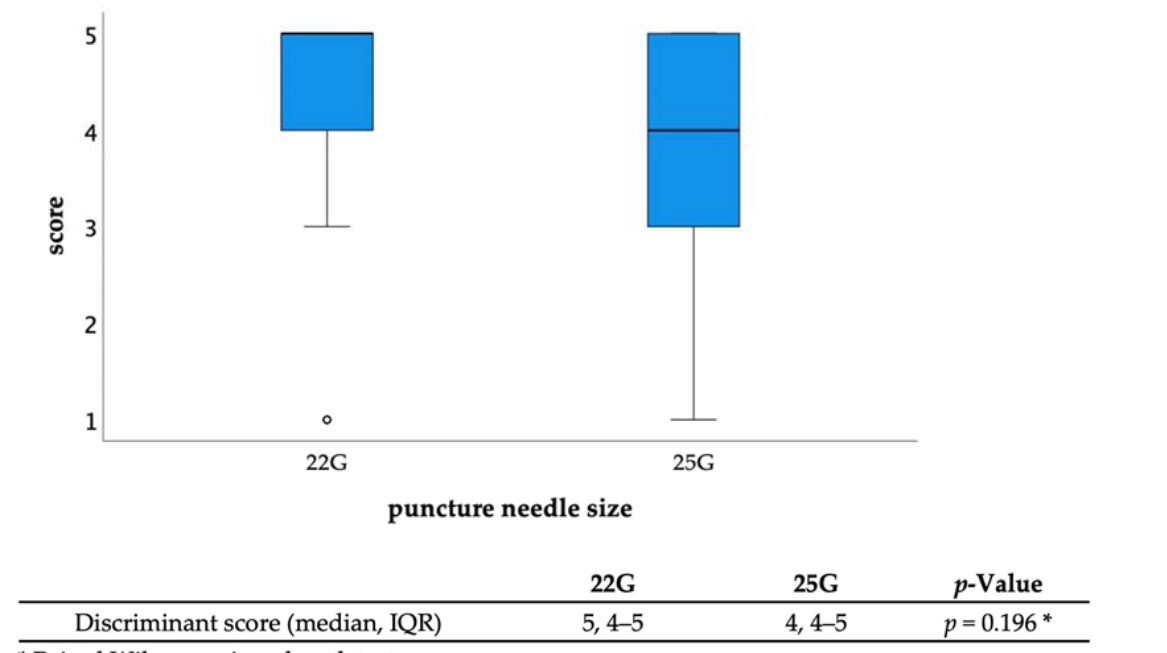
Figure 5. Discriminant scores with different needle sizes (22G vs. 25G). There was no significant difference in the discriminant scores between different puncture needle sizes. Abbreviations: IQR, interquartile range.